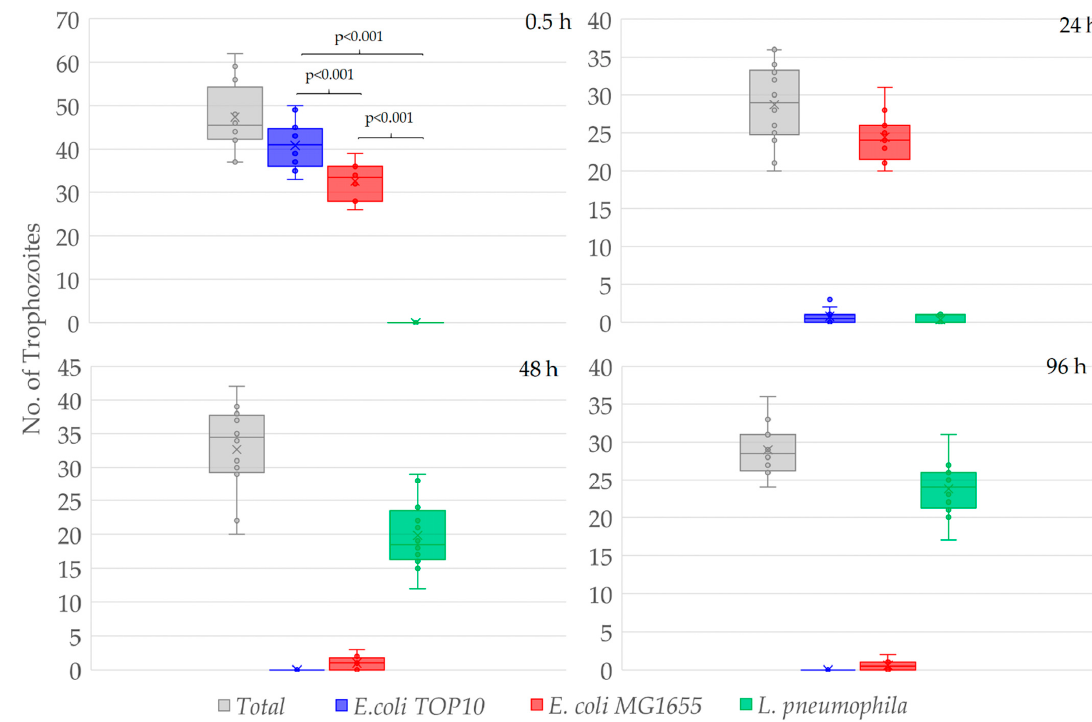
Figure 2. The number of W. magna trophozoites containing E. coli TOP10, E. coli MG1655, and L. pneumophila cells at different time points of co-culture. The number of trophozoites were counted from four fields of view of three replicates (total 48 images/ time point), the bars represent standard deviations of the mean and the box represent 25–75 percentiles. The t -test indicates significant differences in prey preference ( p < 0.001).